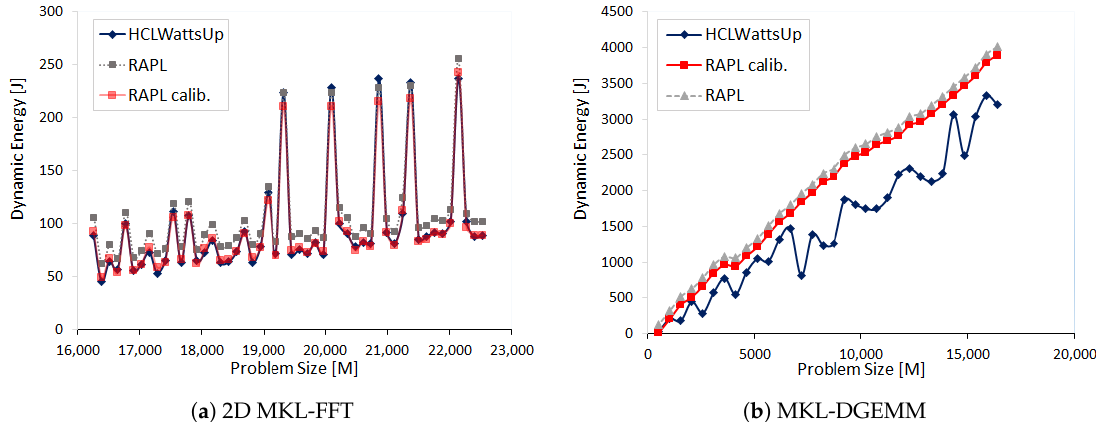
Figure A3. Dynamic energy consumption of RAPL, RAPL calibrated and HCLWattsUp on HCLServer01.